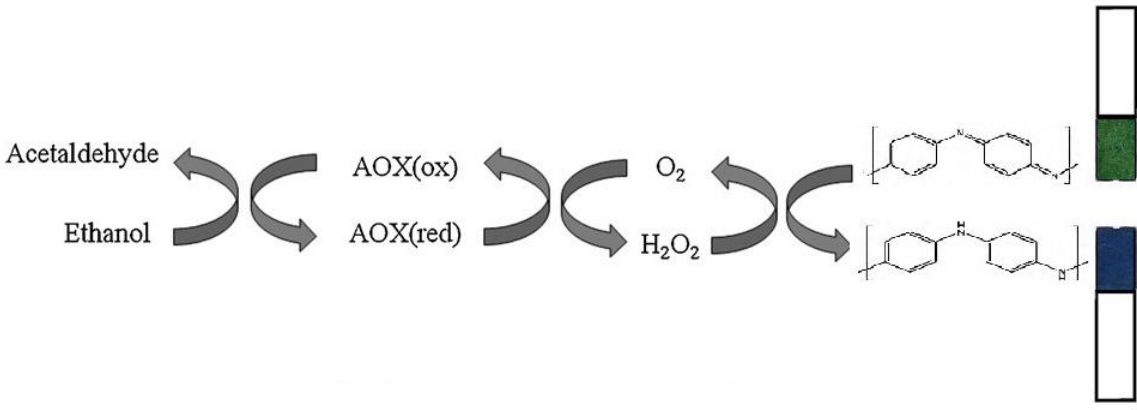
Figure 2. Proposed reaction mechanism at AOX/PANI film based biosensor towards